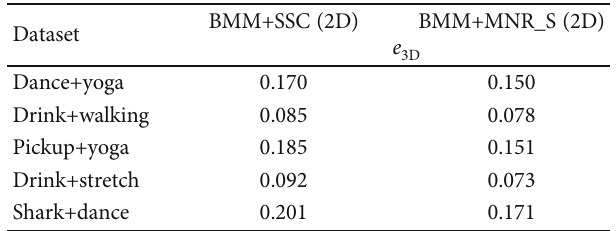
Table 3: The e ff ect of reconstruction using BMM after segmentation in two